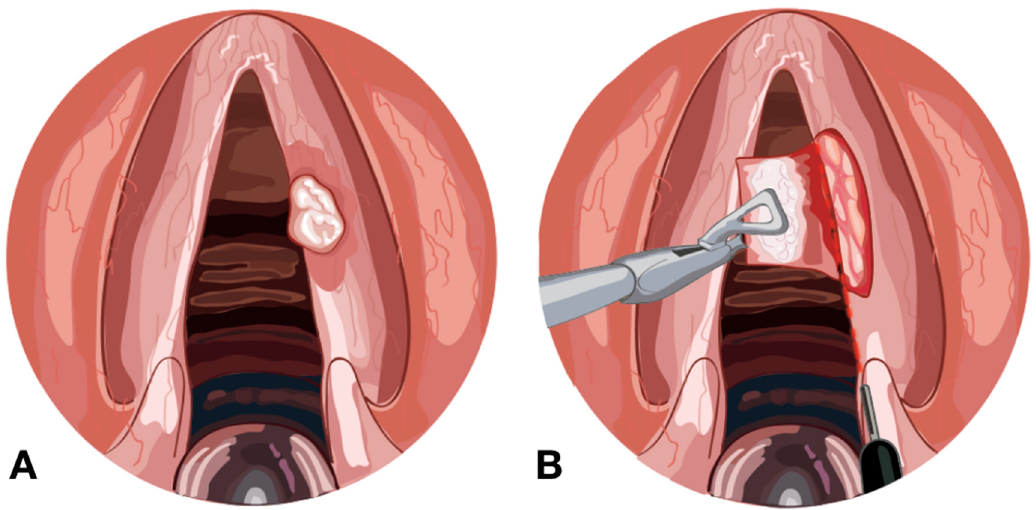
Figure 1. ( A ) Leukoplakia in the right vocal fold. ( B ) CO 2 laser beam delivered through a flexible